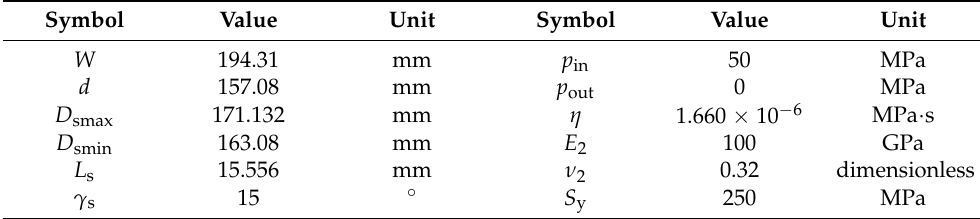
Table 3. Basic parameters for calculating leakage rate of premium